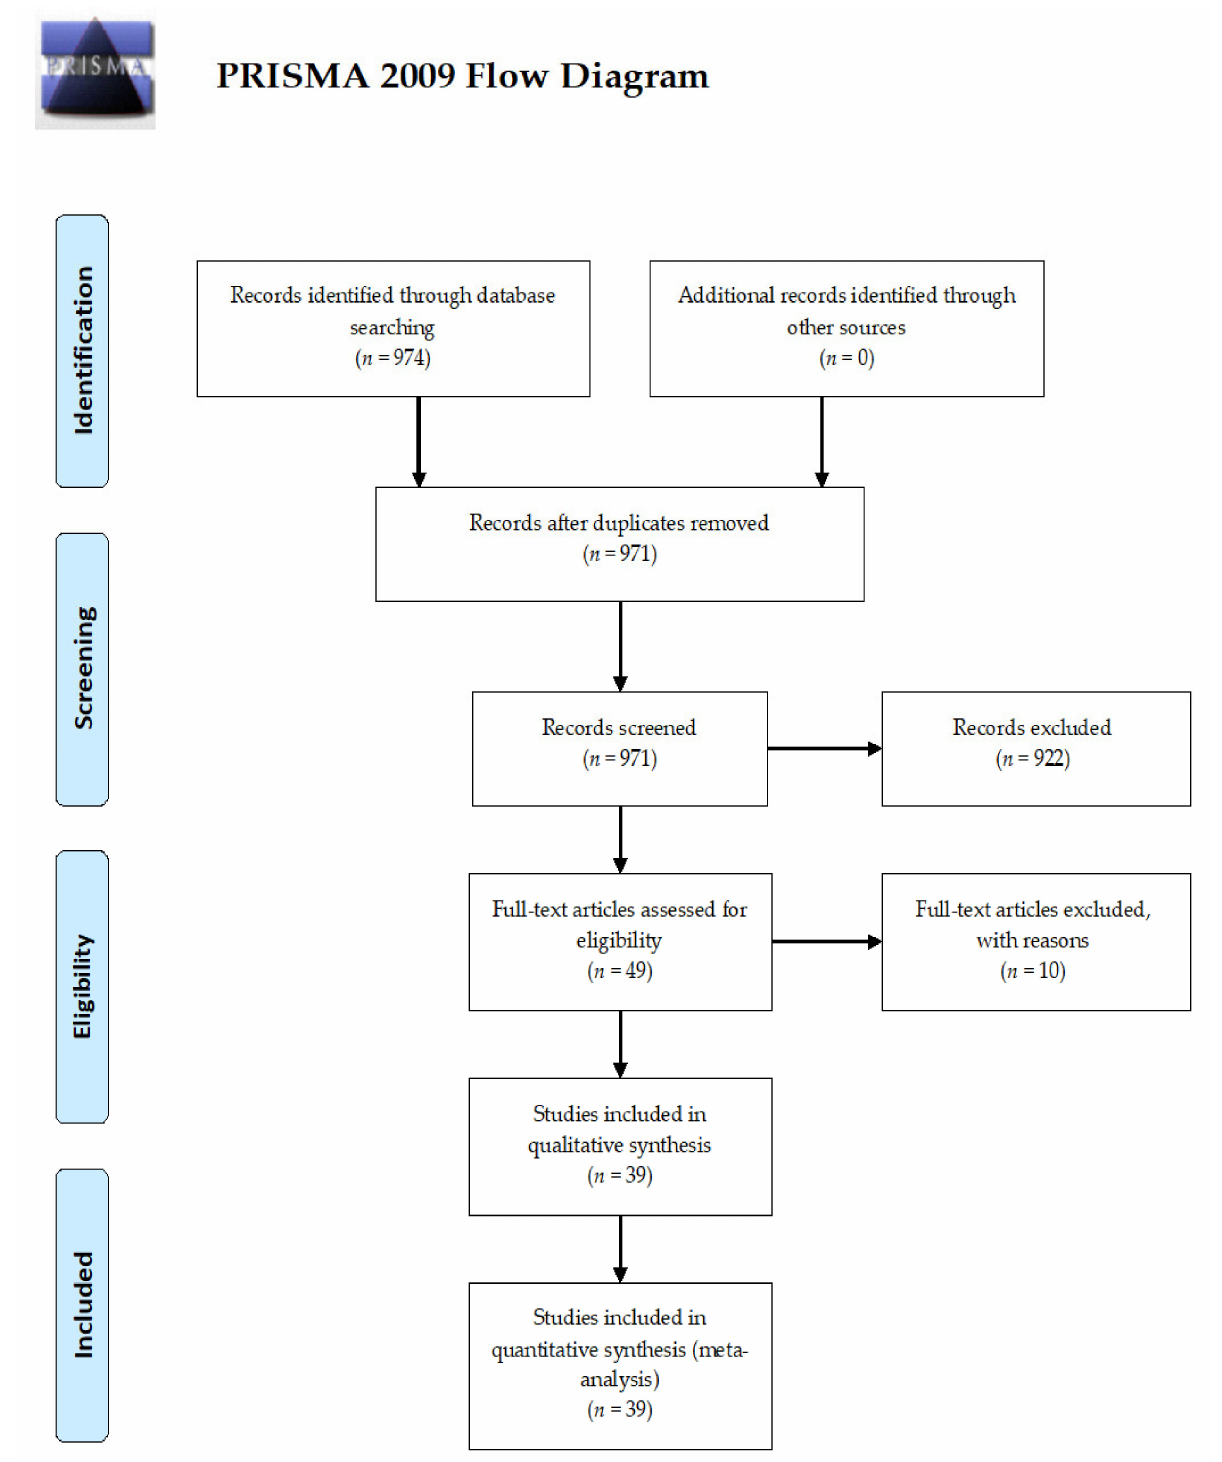
Figure 1. The study retrieval and selection process adopted in the present systematic review and